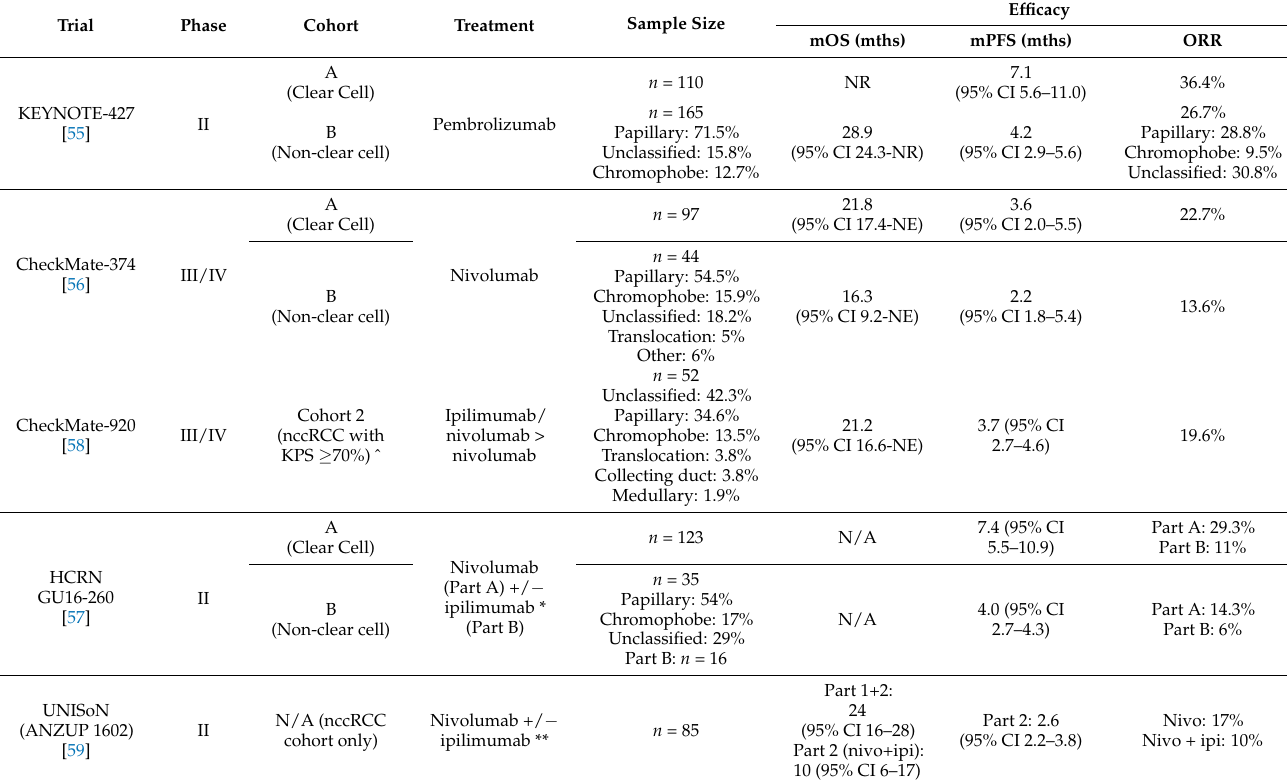
Table 3. Prospective single arm immunotherapy trials in nccRCC [55–59].